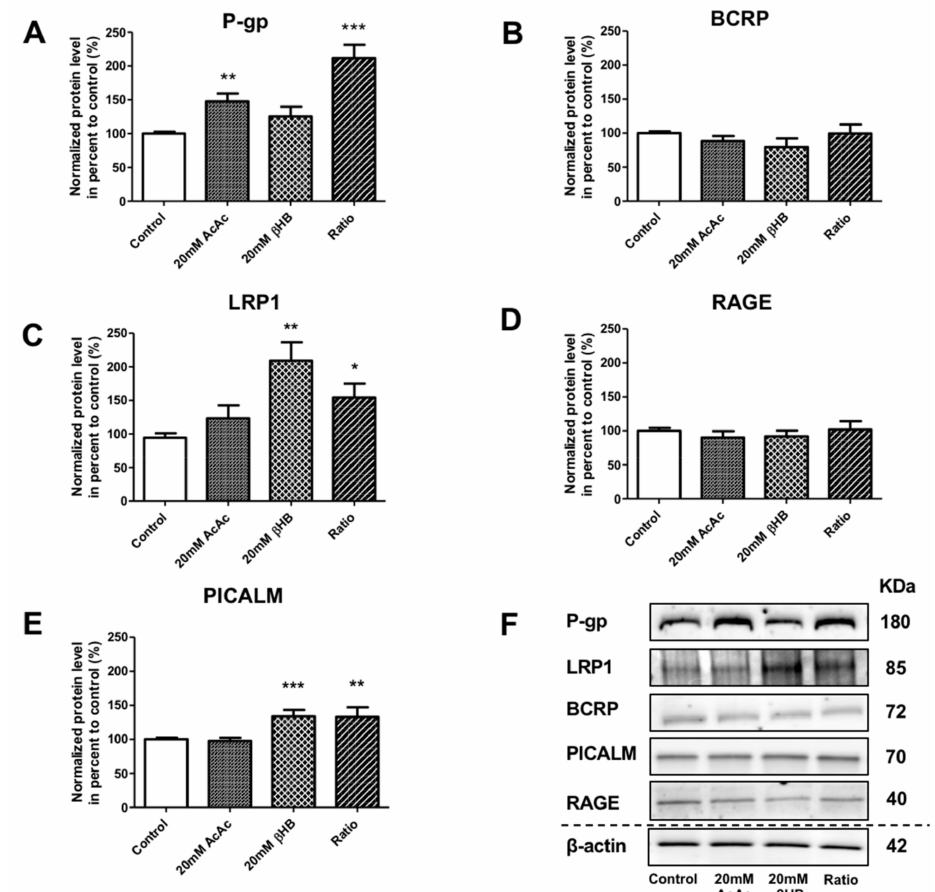
Figure 3. E ff ects of KBs on the protein expression of actors involved in A β peptide transport in BLECs. The protein levels of ( A ) P-gp, ( B ) BCRP, ( C ) LRP1, ( D ) RAGE, and ( E ) PICALM were quantified using Western blot. The data were normalized using β -actin. The results represent the mean ± SEM obtained from at least three independent experiments relative to the control conditions (* p < 0.05, ** p < 0.01, *** p < 0.001). ( F ) The images are representative of at least three independent